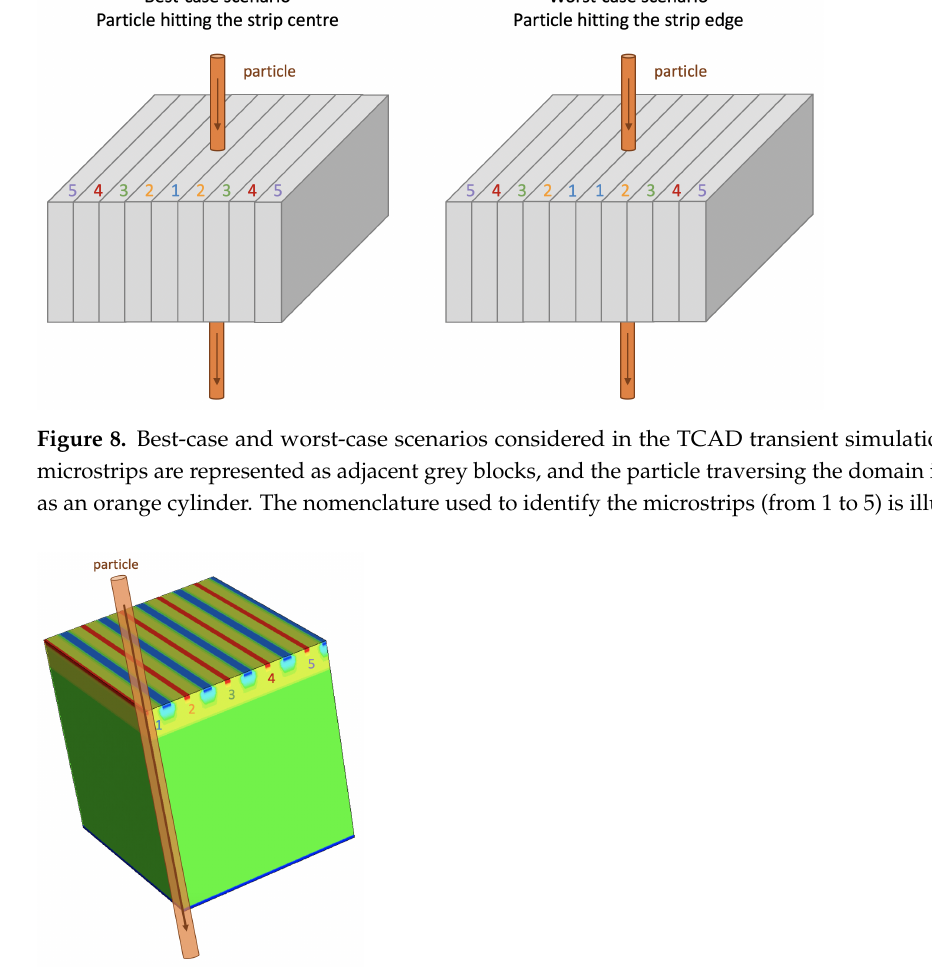
Figure 9. Example reduced TCAD domain used in transient simulations (best-case scenario). The microstrips are labeled following the nomenclature illustrated in Figure 8. A crossing particle is represented as an orange cylinder hitting the corner of the simulated reduced